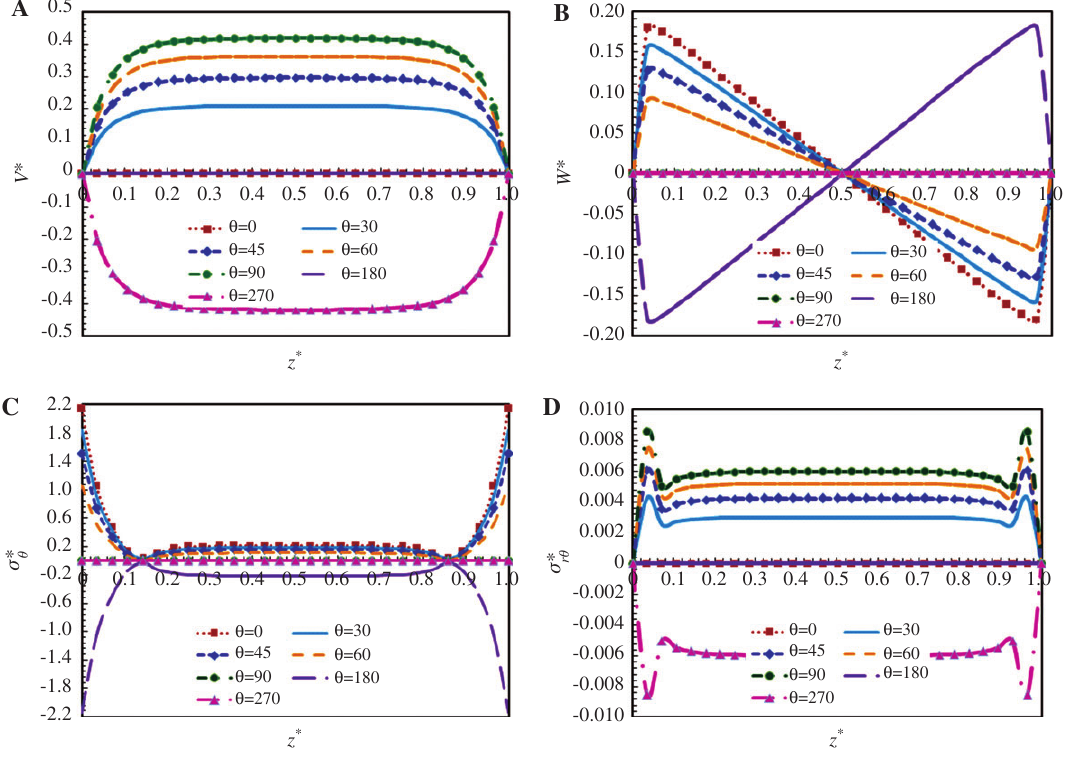
Figure 5 Variations of non-dimensional (A) tangential displacement, (B) axial displacement, (C) tangential stress and (D) shear stress along the length of the cylinder at the inner surface and t * = 1 for different angles θ